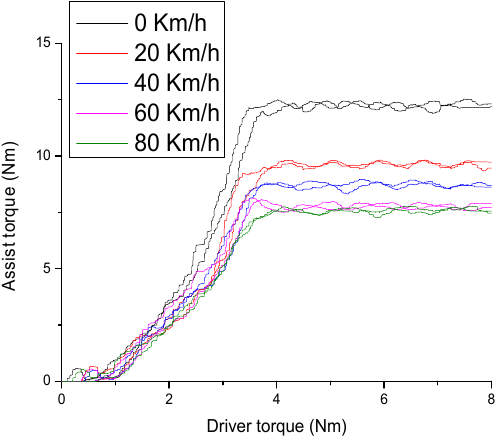
Figure 32. Actual assist characteristic curve under the PID control algorithm with different velocities.